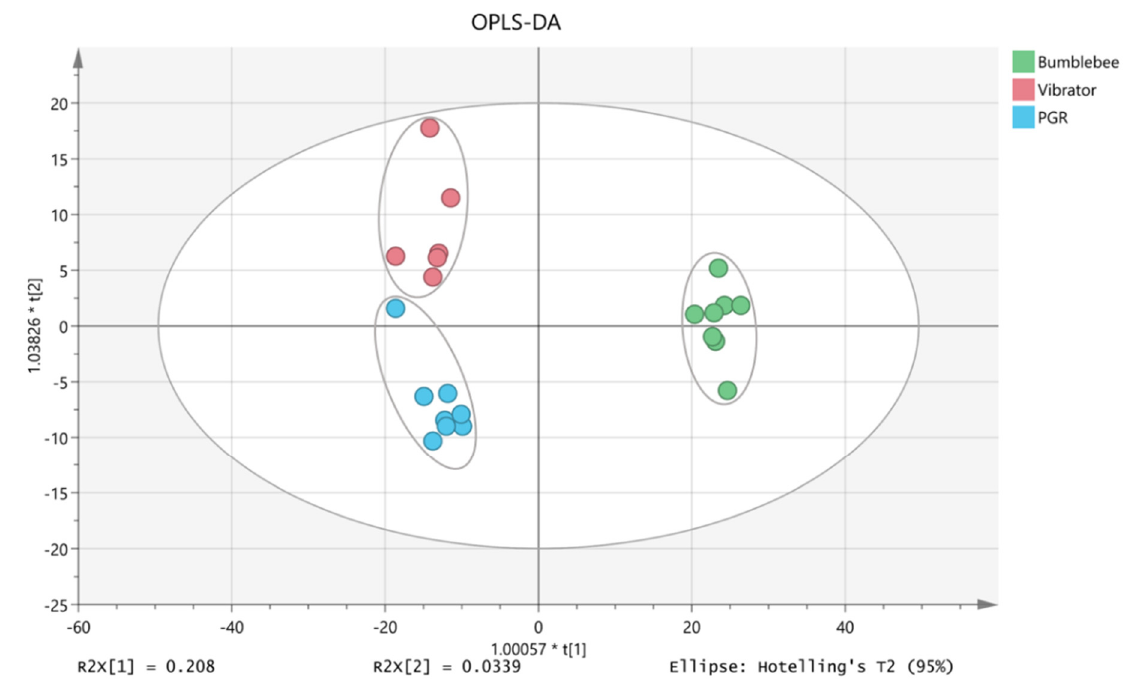
Figure 6. Orthogonal projections to latent structures discriminant analysis (OPLS-DA) of the volatile organic compound profiles of tomato fruits by different pollination treatments. Table 1. Consumer liking related volatile organic compounds from tomato fruit by different pollina- tion